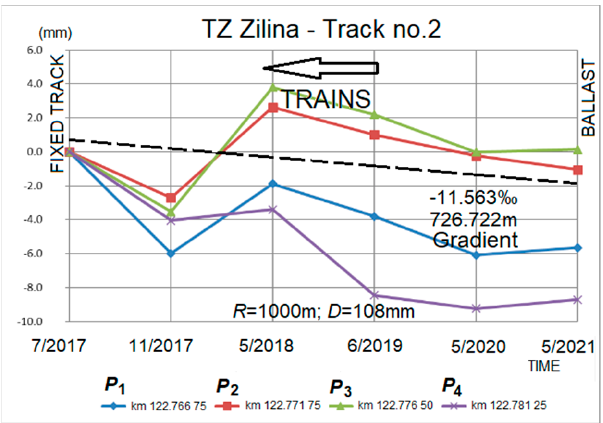
Figure 8. Time dependence of height changes of TZ, towards “Zilina”: Track axis no. 2.